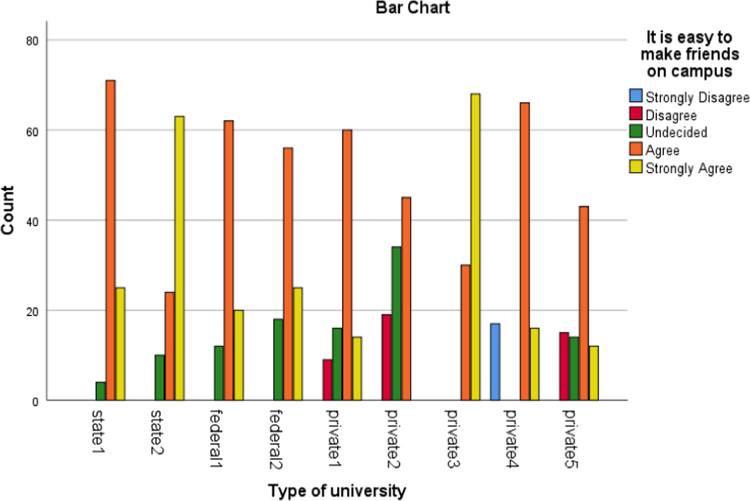
Social Relationship.